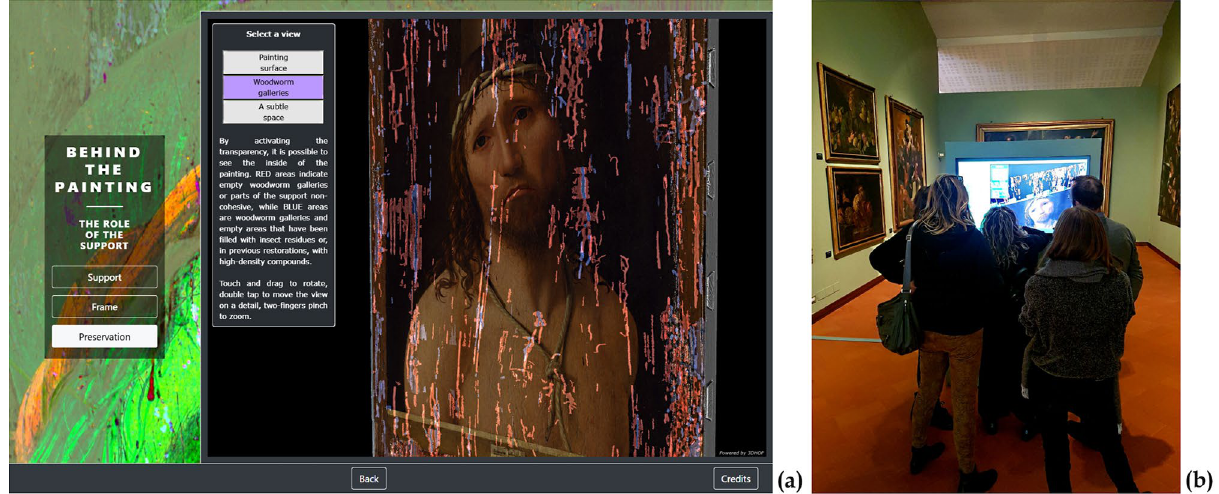
Figure 13. The multimedia kiosk on its inauguration (November 2019). ( a ) A kiosk panel showing the simplified interface of the 3D viewer. Instead of metric tools, three buttons correspond to three bookmarked views that guide visitors through the tunnels and the details of the painting support. ( b ) Visitors interacting with the 3D model through the kiosk touch screen.